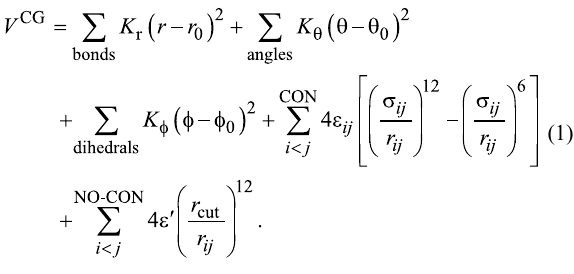
The first three terms on the right hand side of Equation 1 corre- spond to the harmonic pseudo-bond, bond angle and dihedral potentials. The values of the elastic constants were derived from all-atom simulations [45] and are K r = 100 kcal/mol/Å 2 , K θ = 45 kcal/mol/rad 2 and = 5.0 kcal/mol/rad 2 . The choice of equilibrium values r 0 , θ 0 , and are based on two, three, and four α -C atoms, respectively, and are meant to favour the native geometry. The fourth term on the right-hand side of Equation 1 takes into account the non-bonded contact interactions, de- scribed by the Lennard-Jones potential. Here, we take ε ij to be uniform and equal to ε = 1.5 kcal/mol, which was also derived from all-atom simulations [45]. Our approach has shown very good agreement with experimental data on stretching [46,47] and nanoindentation of biological fibrils, such as virus capsids [35] and β -amyloids [36]. The strength of the repulsive non- native term, ε ’, is set equal to ε . Our CG model takes into account native distances as in the case of a G ō -like model [37]. Hence, the native contacts are determined by the overlap crite- rion [48]. In practice, each heavy atom is assigned to a van der Waals radius, as proposed by Tsai and co-workers [49]. A sphere with the radius enlarged by a factor of 1.24 is built around the atom. If two amino acids have heavy atoms with overlapping spheres, then we consider a native contact between those two C α atoms. In Figure 2, we show the CG representa- tion for some biological fibrils as well as their native interac- tions. These native contacts represent hydrogen bonds